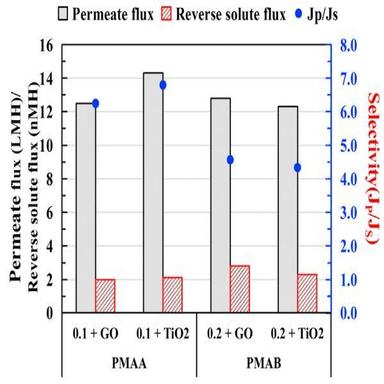
FO performance of TFN membranes of PMAA and PMAB with additional hydrophilic nanoparticles GO, and TiO2.